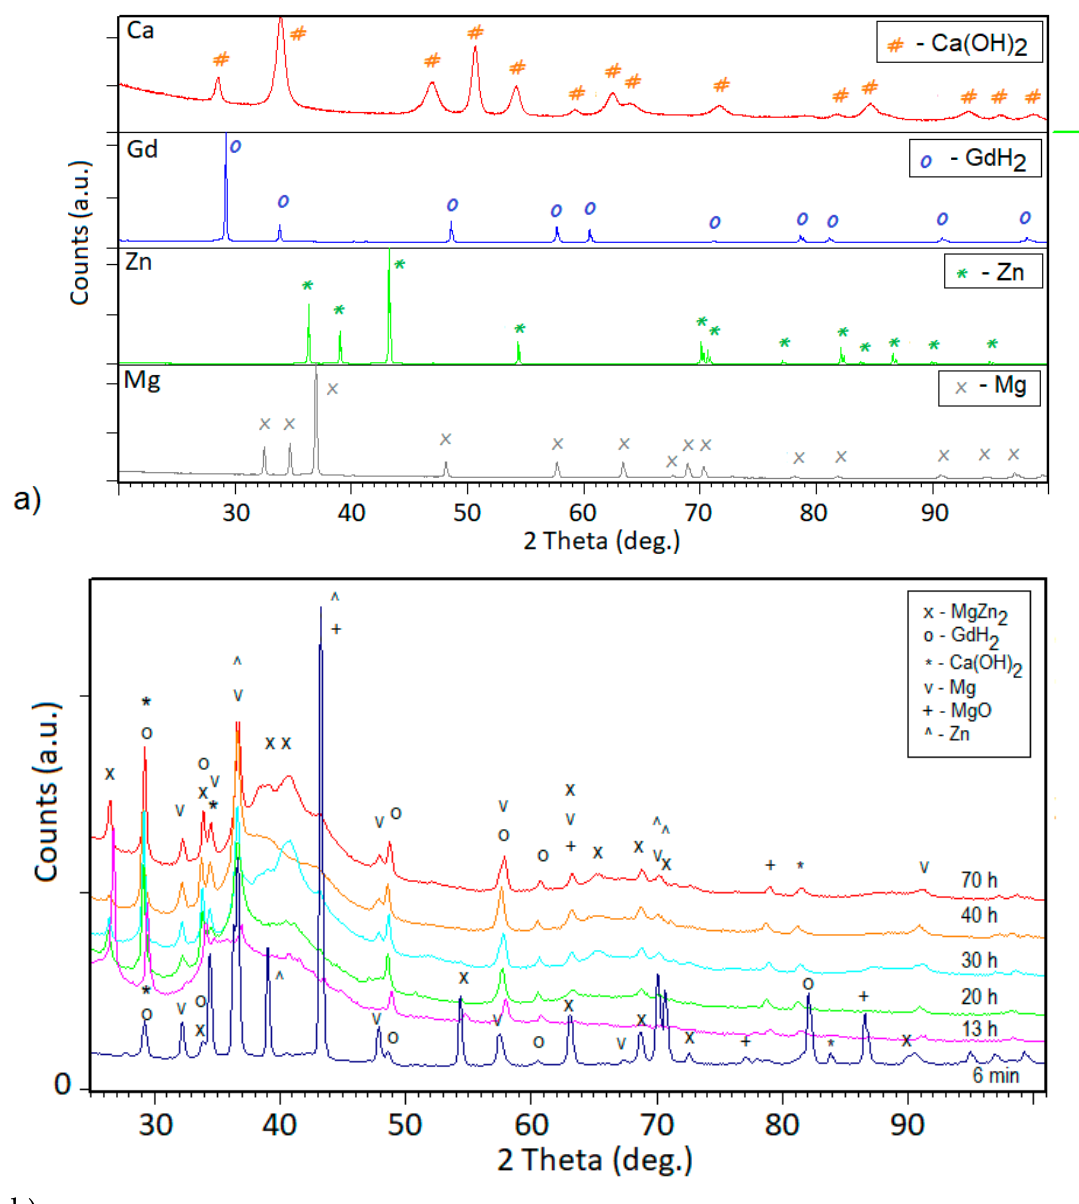
Figure 2. The X-ray diffraction patterns obtained for ( a ) Ca, Gd, Zn, Mg initial powders; ( b ) Mg 65 Zn 30 Ca 4 Gd 1 powder alloy samples synthesized after 6 min, 13, 20, 30, 40, and 70 h of milling time, respectively. The most important peaks of main identified phases are labeled according to the ICDD PDF4+ 2016 data base (MgZn 2 , 03-065-0120; GdH 2 , 01-089-4063; Ca(OH) 2 , 00-004-0733; Mg, 00-001-1141; MgO, 00-003-0998; Zn, 03-065-3358).